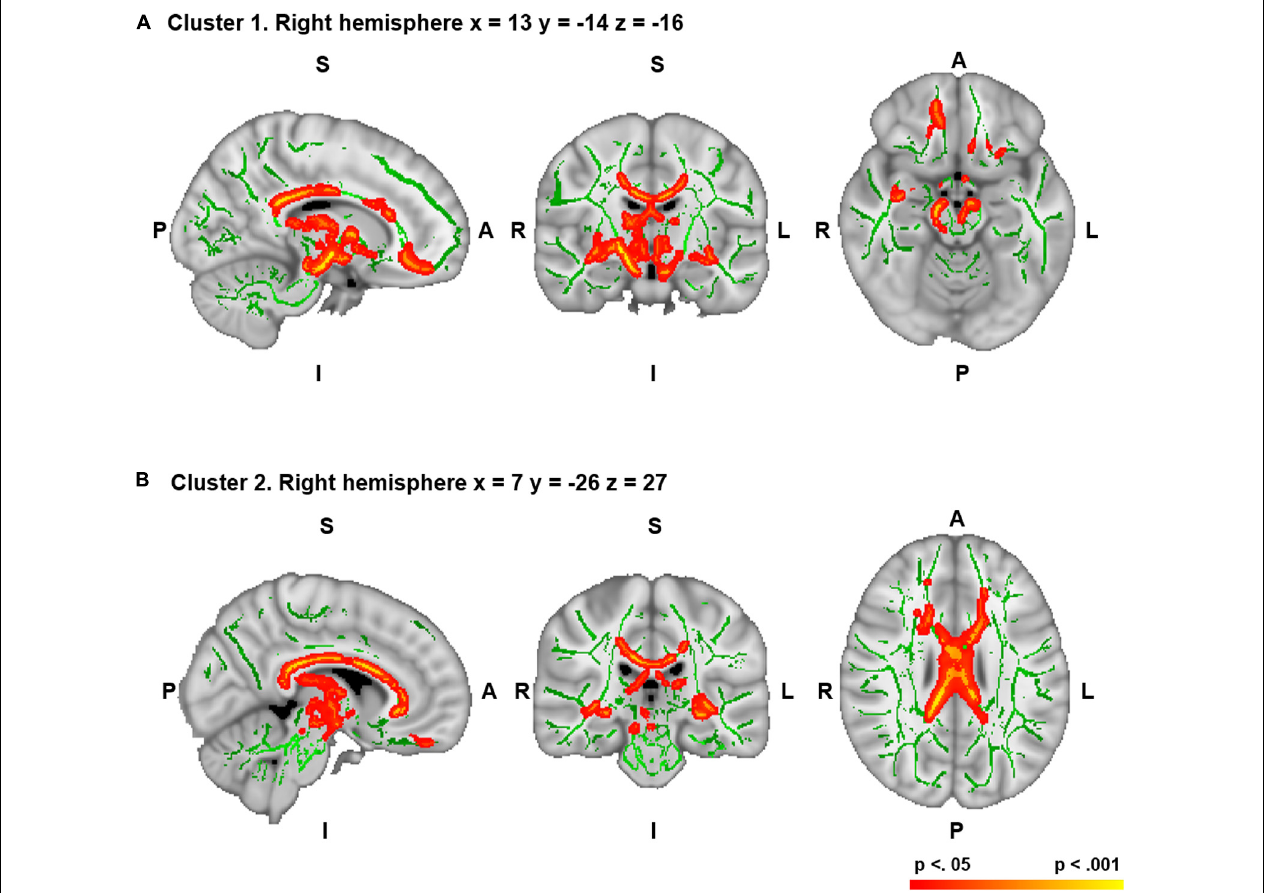
FIGURE 1 | Correlations between figural originality and white matter (WM) mean fractional anisotropy (FA) in the two significant clusters [ (A) for cluster 1 and (B) for cluster 2]. Correlations are significant at p < 0.05 corrected for family wise error (FWE). Significant WM regions are shown in red-yellow; the WM skeleton is shown in green. Significant voxels are thickened for easier visualization. S, superior; I, inferior; A, anterior; P, posterior; L, left; R, right. Coordinates are shown in Montreal Neurological Institute (MNI) space. The region located in the coordinates that showed the maximum significance was the right cerebral peduncle of the corticospinal tract for cluster 1 (A) and the right body of the corpus callosum for cluster 2 (B)